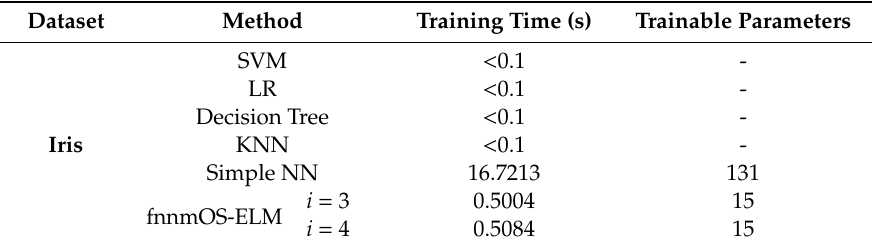
Table 2. Training time and parameters on the Iris dataset.